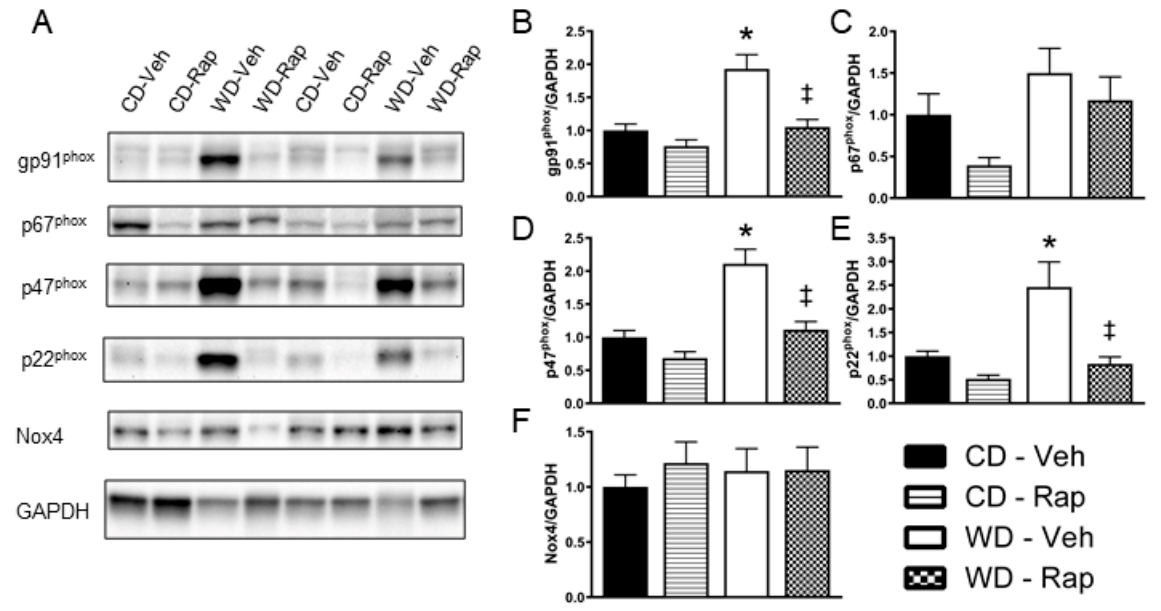
Figure 4. Assessment of NADPH oxidase subunit protein content in the corpus cavernosum. Mice were fed the control (CD) or Western (WD) diet and treated with vehicle or 2 mg/kg rapamycin (Rap). ( A ) Representative immunoblot images for the NADPH oxidase subunits and the loading control GAPDH. Quantification of band intensity density normalized to GAPDH for: ( B ) gp91 phox ; ( C ) p67 phox ; ( D ) p47 phox ; ( E ) p22 phox ; ( F ) Nox4. Data are presented as mean ± standard error of the mean for n = 8 – 9 mice per group; * p < 0.05 vs. CD-Veh, ‡ p < 0.05 vs. WD-Veh.